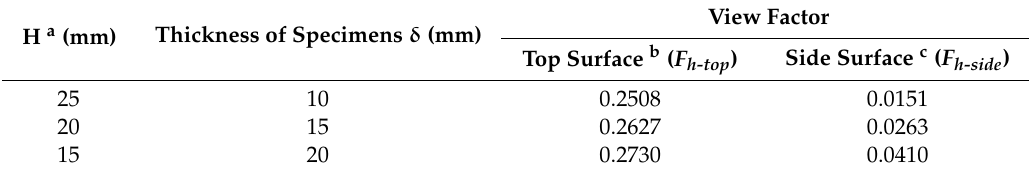
Table 1. View factors calculated for configuration between the standard-sized heater and steel